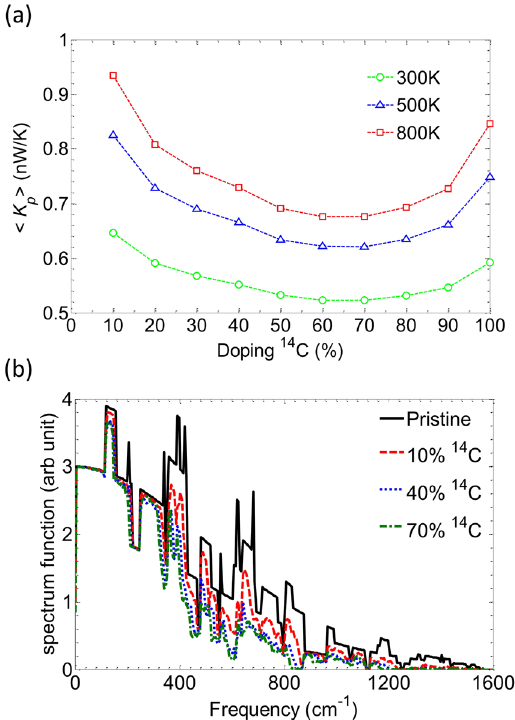
Figure 3. ( a ) Average phonon conductance as a function of 14 C concentration. ( b ) Phonon energy spectrum versus frequency defining the frequency range impacted by isotopes. Data provided for M = 5, N A = 30 ( L A = 12.64 nm) nanoribbons.